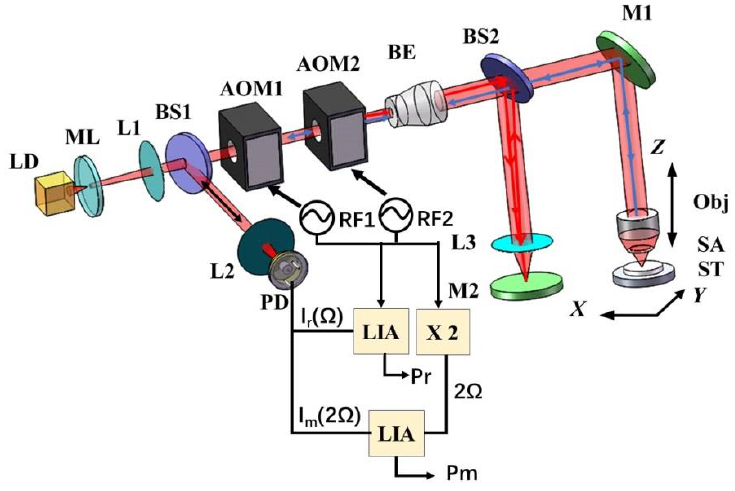
Figure 21. Schematic of the surface measurement system. ML: microchip laser; L1–L3: lenses; BS1 and BS2: beam splitters; PD: photodiode; RF1 and RF2: reference signal generators; LIA: lock-in amplifiers; AOM1 and AOM2: acousto-optical demodulators; BE: beam expander; M1 and M2: reflect mirrors; Obj: objective lens; SA: sample; ST: stage. (Figure reproduced from Ref. [87]).